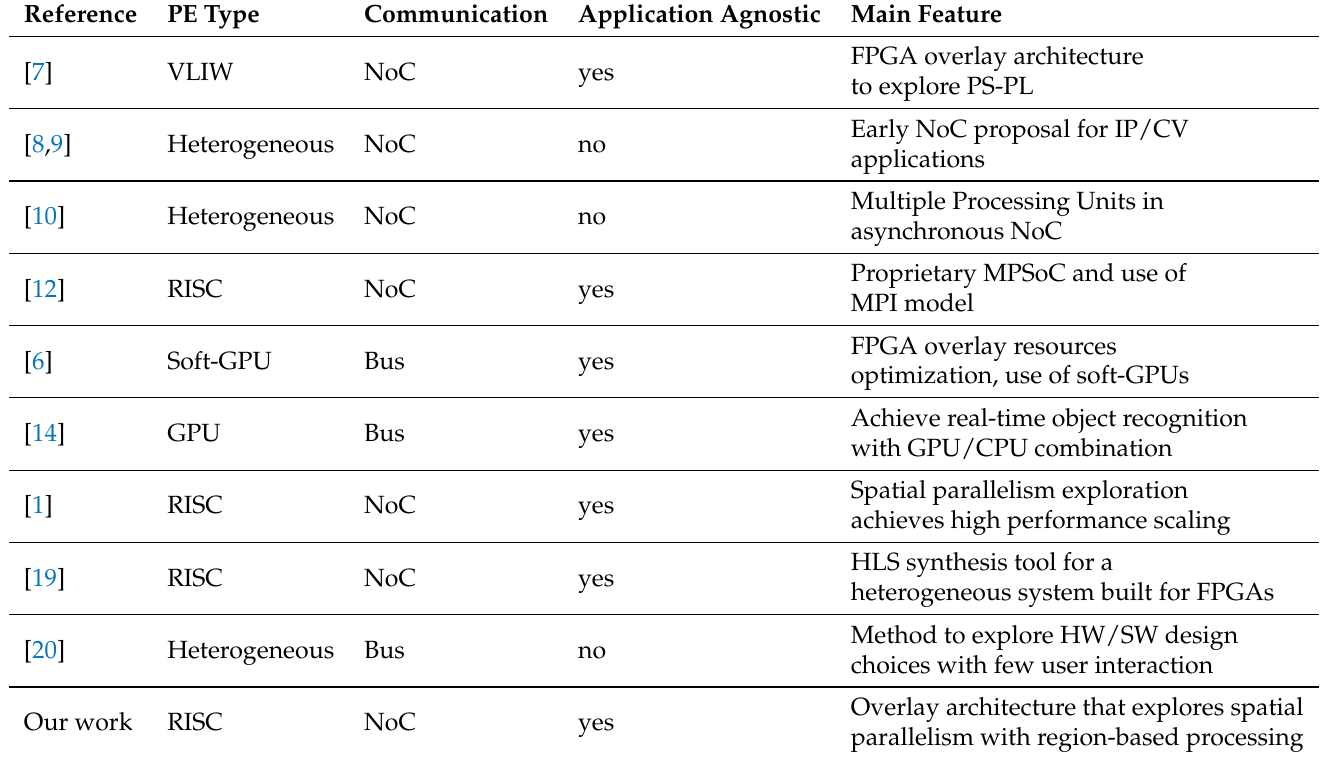
Table 1. IP/CV reference comparison.